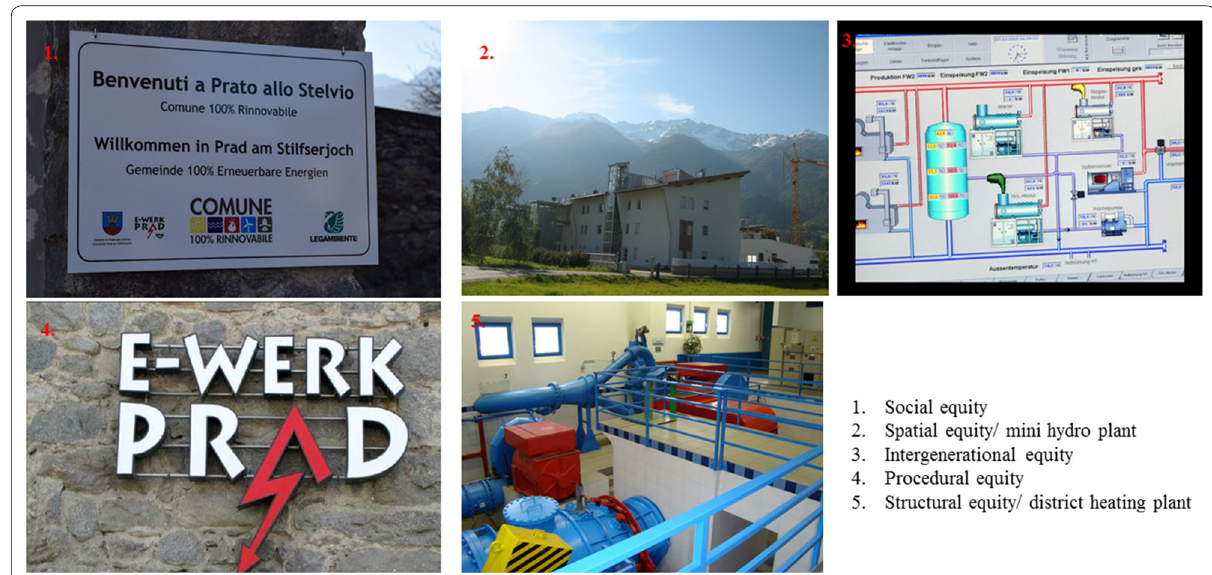
Fig. 3 The principle of equity postulated in a best practice of collaboration and shared choices—City of Prato allo Stelvio and E-Werk Prad Coopera- tive (Source: 1. http://www.comun e.prato .bz.it/syste m/web/defau lt.aspx?sprac he stelv io/-3. http://www.e-werk-prad.it-4. http://www.e-werk-prad.it-5.